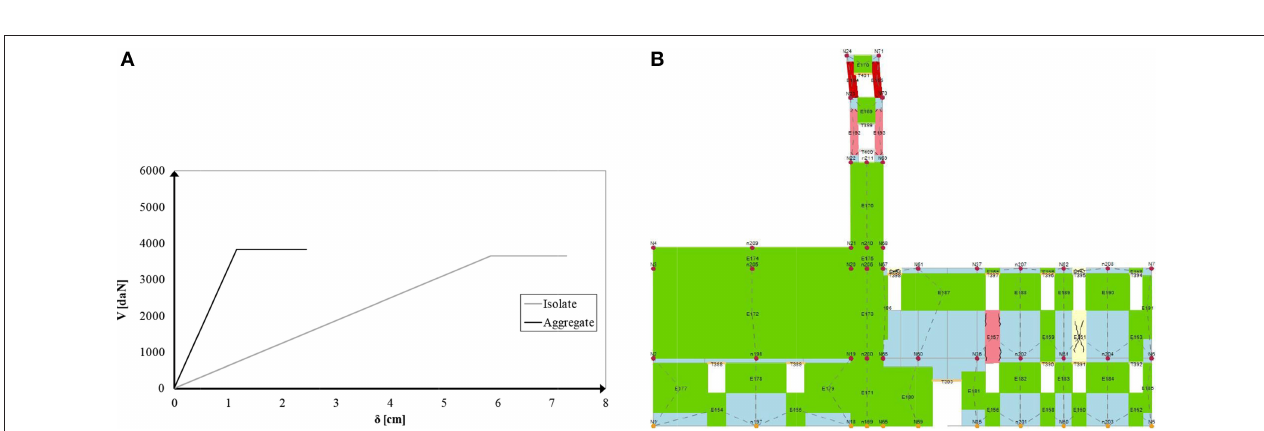
FIGURE 7 | 3D geometrical (A) and macro-element (B) models of the whole church.